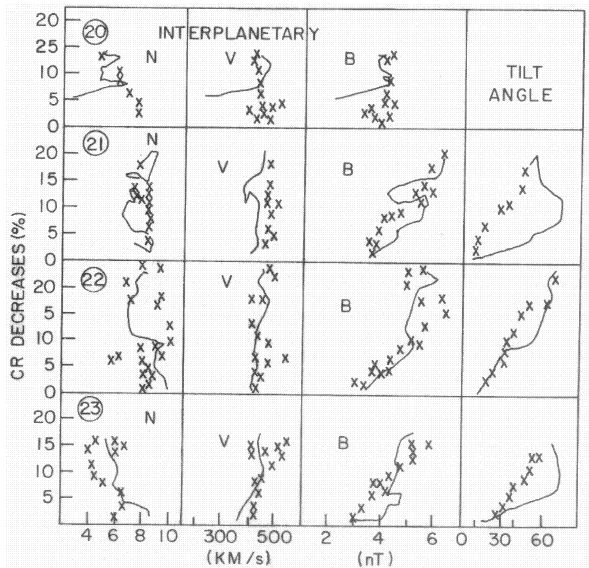
Fig. 6. Hysteresis plots of Cosmic Ray (CR) intensity (ordinate in percent, 3-monthly values) versus interplanetary parameters N , V , B and Tilt angle (abscissa, scale arbitrary, adjusted to suite available space).